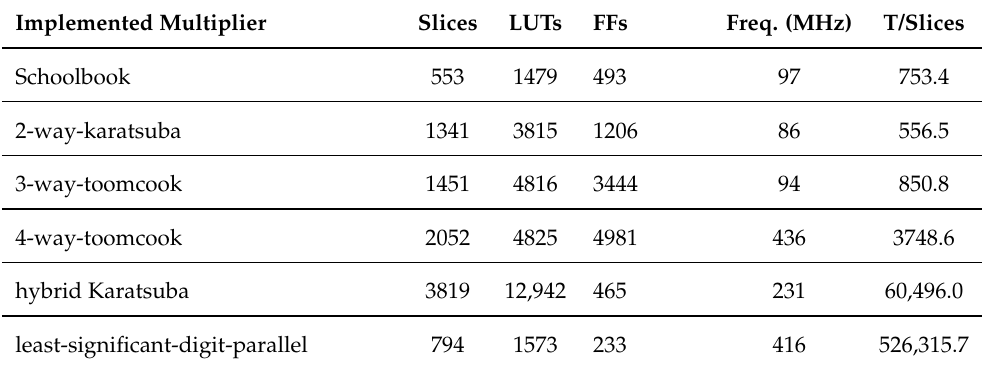
Table 4. Implementation results of the multipliers over GF ( 2 233 )